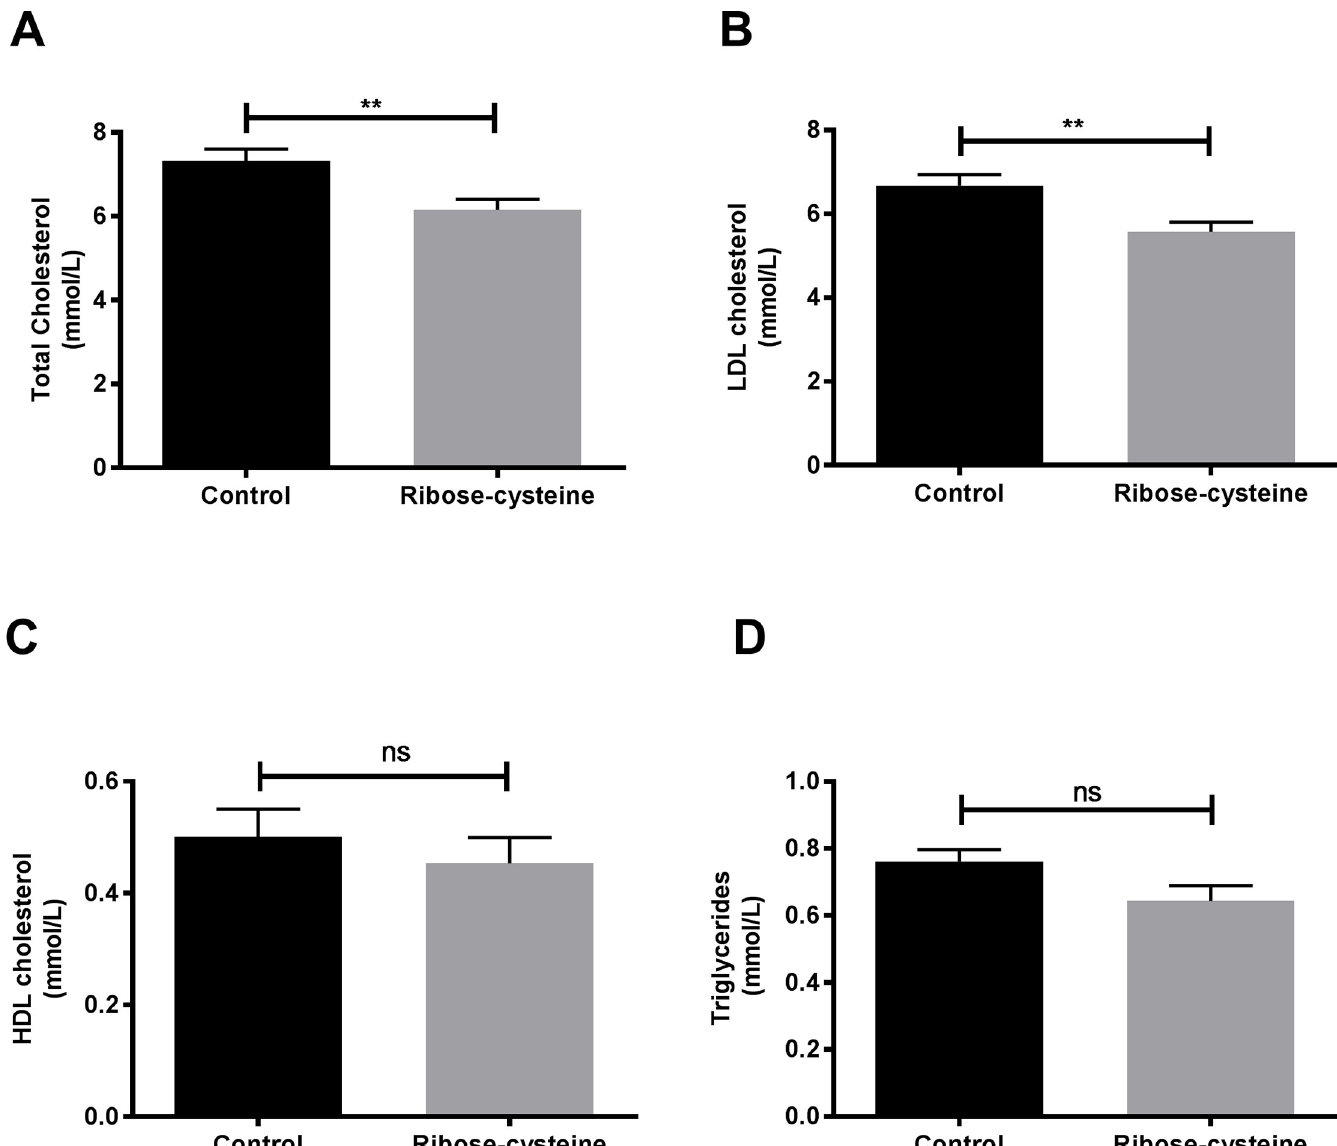
Fig 3. Ribose-cysteine decreases total plasma and LDL cholesterol in apoE-/-mice. Total plasma cholesterol, HDL cholesterol and triglyceride levels were measured in ribose-cysteine treated and control apoE-/- mice (n = 15 per group) by enzymatic assay. LDL cholesterol levels were calculated by the Friedewald equation. (A) Total cholesterol, (B) LDL cholesterol, (C) HDL cholesterol, (D) Triglycerides. �� p < 0.005. Error bars indicate means ± SEM.